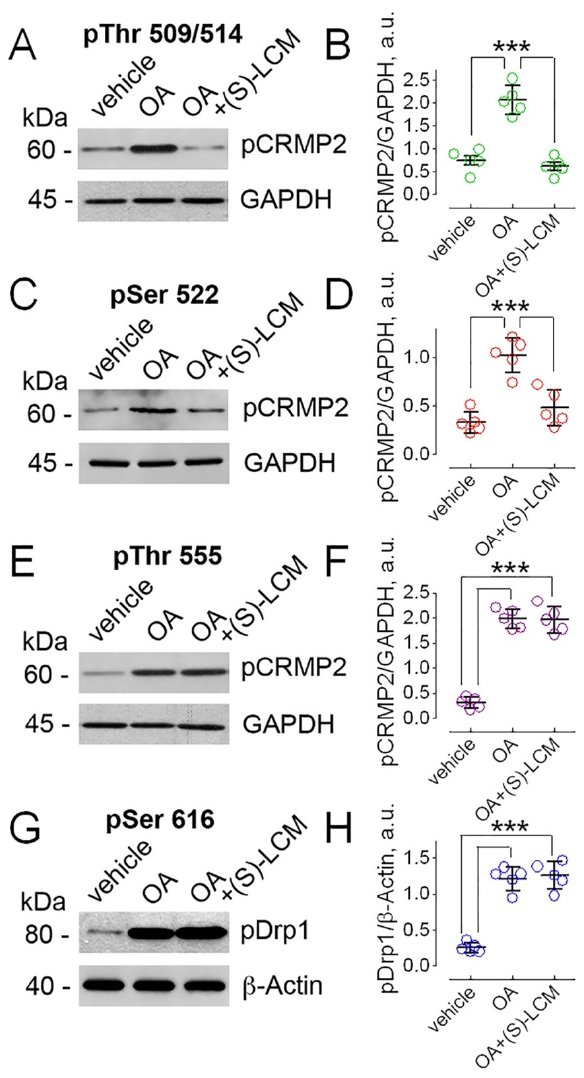
Figure 3. Inhibition of PP1 and PP2A in mouse striatal neurons treated with okadaic acid (OA) increased CRMP2 phosphorylation at Thr509/514, Ser522, and Thr555, and increased Drp1 phosphorylation at Ser616. (S)-lacosamide ((S)-LCM) prevented CRMP2 phosphorylation at Thr509/514 and Ser522 but not at Thr555 and Drp1 phosphorylation at Ser616. Neurons were treated with 20 nM OA and/or 30 µ M (S)-LCM for 16 h as indicated. 0.01% DMSO was used as a vehicle. GAPDH and β -actin are loading controls. In ( A , C , E , G ), representative Western blots are shown. In ( B , D , F , H ) pCRMP2 or pDrp1 densitometry data, normalized per GAPDH or β -actin, are shown. Data are mean ± SD. The colored circles indicate data from individual measurements. In ( B , D) , *** p < 0.001 comparing vehicle with OA and OA with OA plus (S)-LCM, n = 5 separate, independent experiments. In ( F , H ), *** p < 0.001 comparing vehicle with OA and OA plus (S)-LCM, n = 5 separate, independent